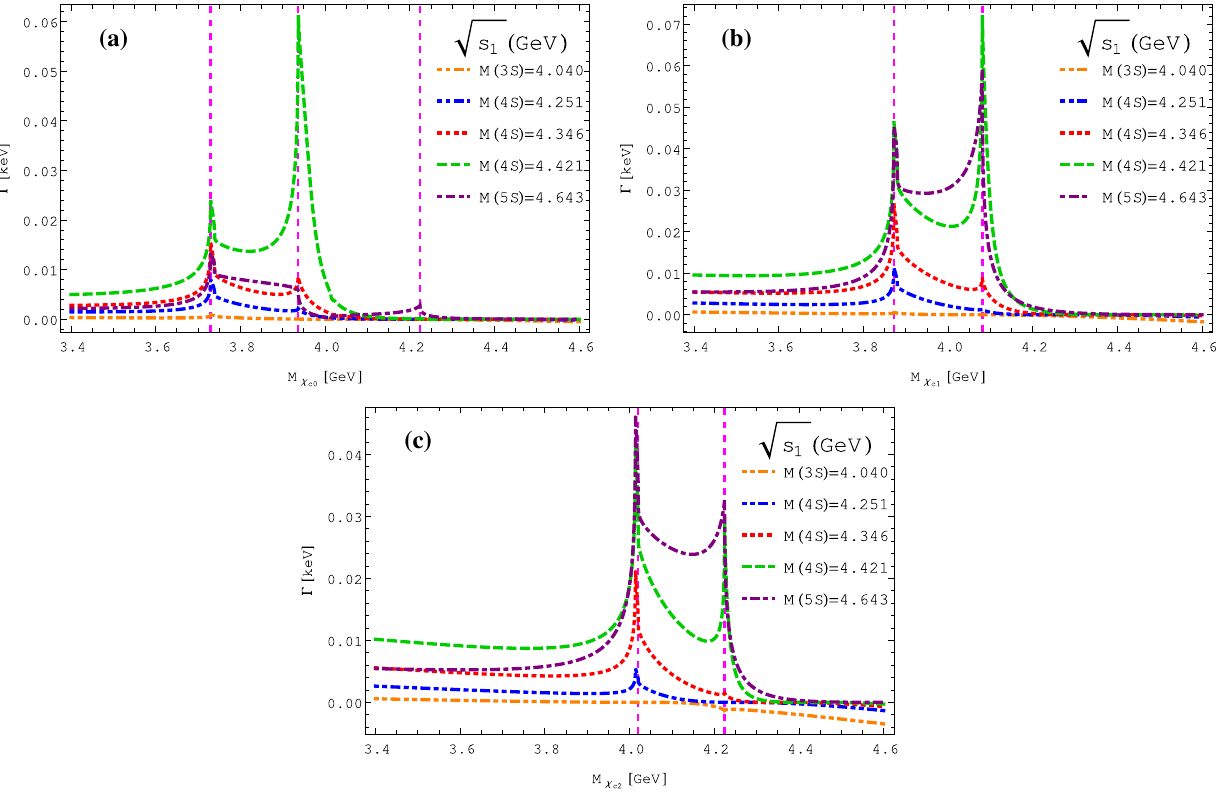
Fig. 3 M χ dependence of the partial widths of ψ( nS ) → γχ cJ . The vertical dashed lines indicted a : D 0 ¯ D 0 threshold, D + s D − s threshold, and cJ D ∗+ s D ∗− s threshold, respectively; b : D ∗+ s D − s threshold; c : D ∗+ D ∗− and D ∗+ s D ∗− s threshold, χ c 2 (3P)(NR),